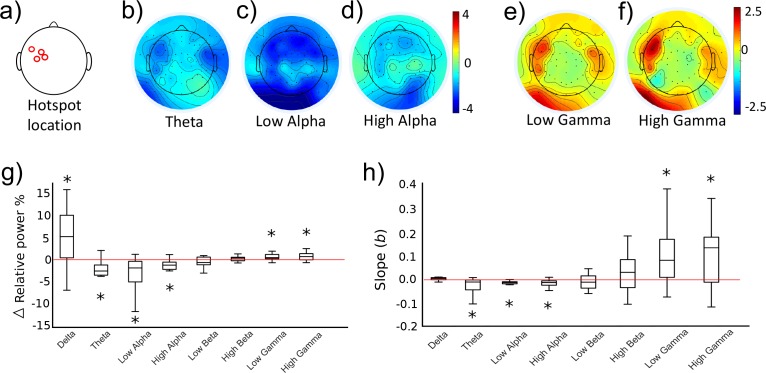
Neural oscillations associated with the trained brain states.Panels (b-f) show topographical representations of the relative power (in % of whole spectrum) in the UP condition minus the DOWN condition, for five distinct frequency bands (averaged group data, n = 14, three other frequency bands shown in Figure 5—figure supplement 2). Red colours indicate regions that demonstrated greater synchronisation in the UP condition. Blue colours indicate greater synchronization in the DOWN condition. The location of the electrode nearest to the TMS hotspot varied between participants but was always within the region indicated in panel (a). Colours are scaled from blue-red by minimum-maximum (range shown to right of each plot). Panel (g) shows the same data (UP-DOWN) extracted for each participant’s hotspot electrode. Values greater than 0 indicate larger amplitude oscillations in the UP condition, and lower than 0 indicate larger oscillations in the DOWN condition. Stars indicate significant deviations from 0 (Wilcoxon Signed Rank tests). Panel (h) shows group level data for regression analyses performed on MEP amplitudes with relative power in each frequency band. This included all 120 trials (60 UP, 60 DOWN) collected during the combined TMS-EEG recording session. The Y axis depicts the slope of the regression model. Stars indicate significant deviations from 0 (0 would indicate no slope, Wilcoxon Signed Rank test). Individual regression plots are shown for one representative participant in Figure 5—figure supplement 3.